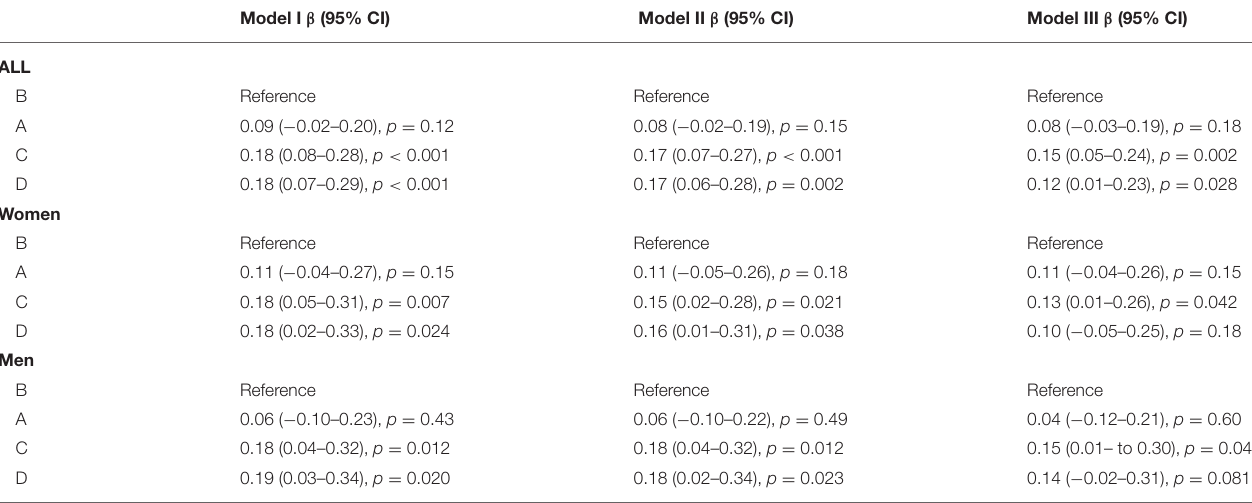
TABLE 2 | Regression models predicting pulse wave velocity 15 years later based upon body composition groups in men and women combined and separately in women and